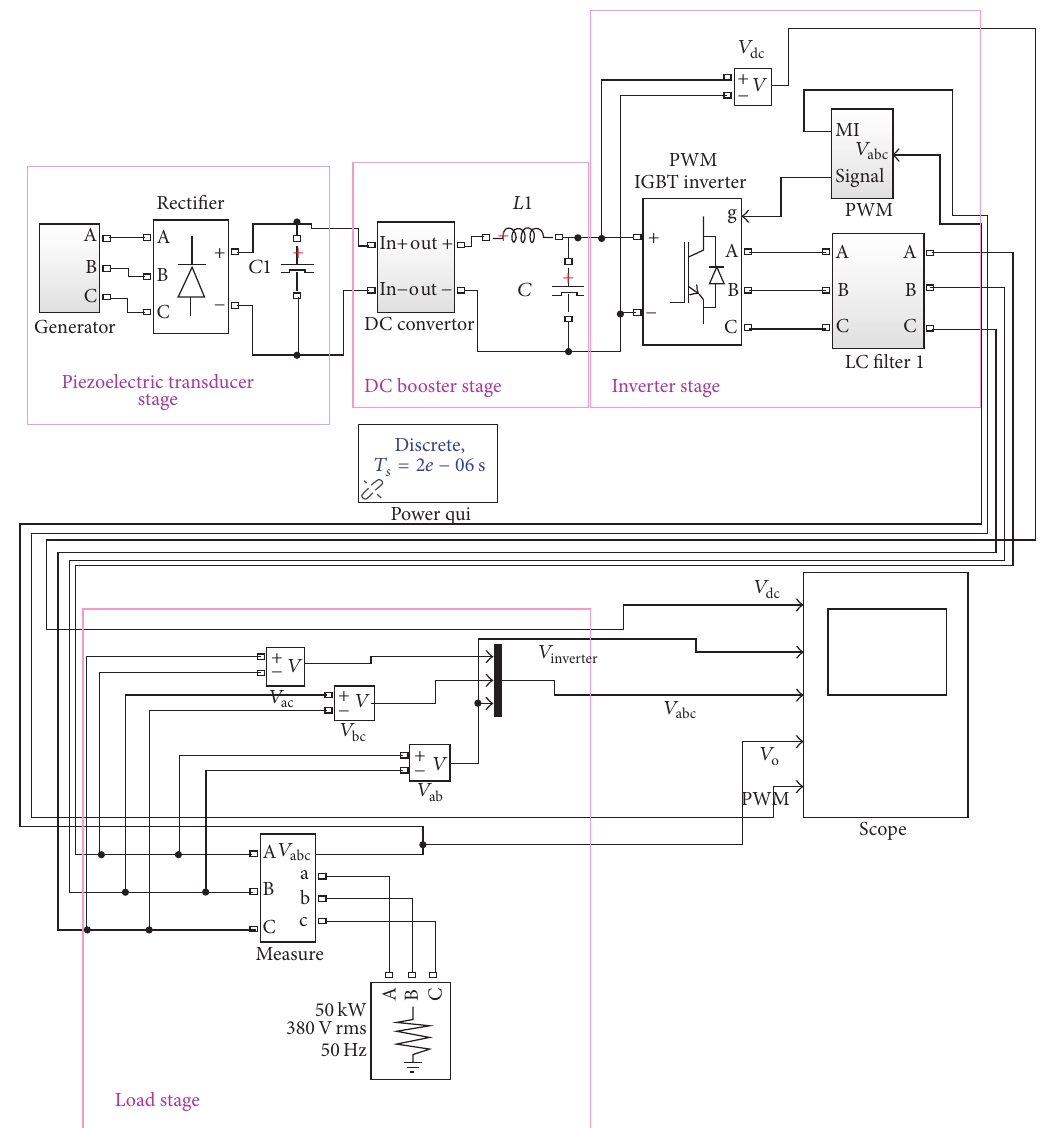
Figure 3: Design implementation of Simulink